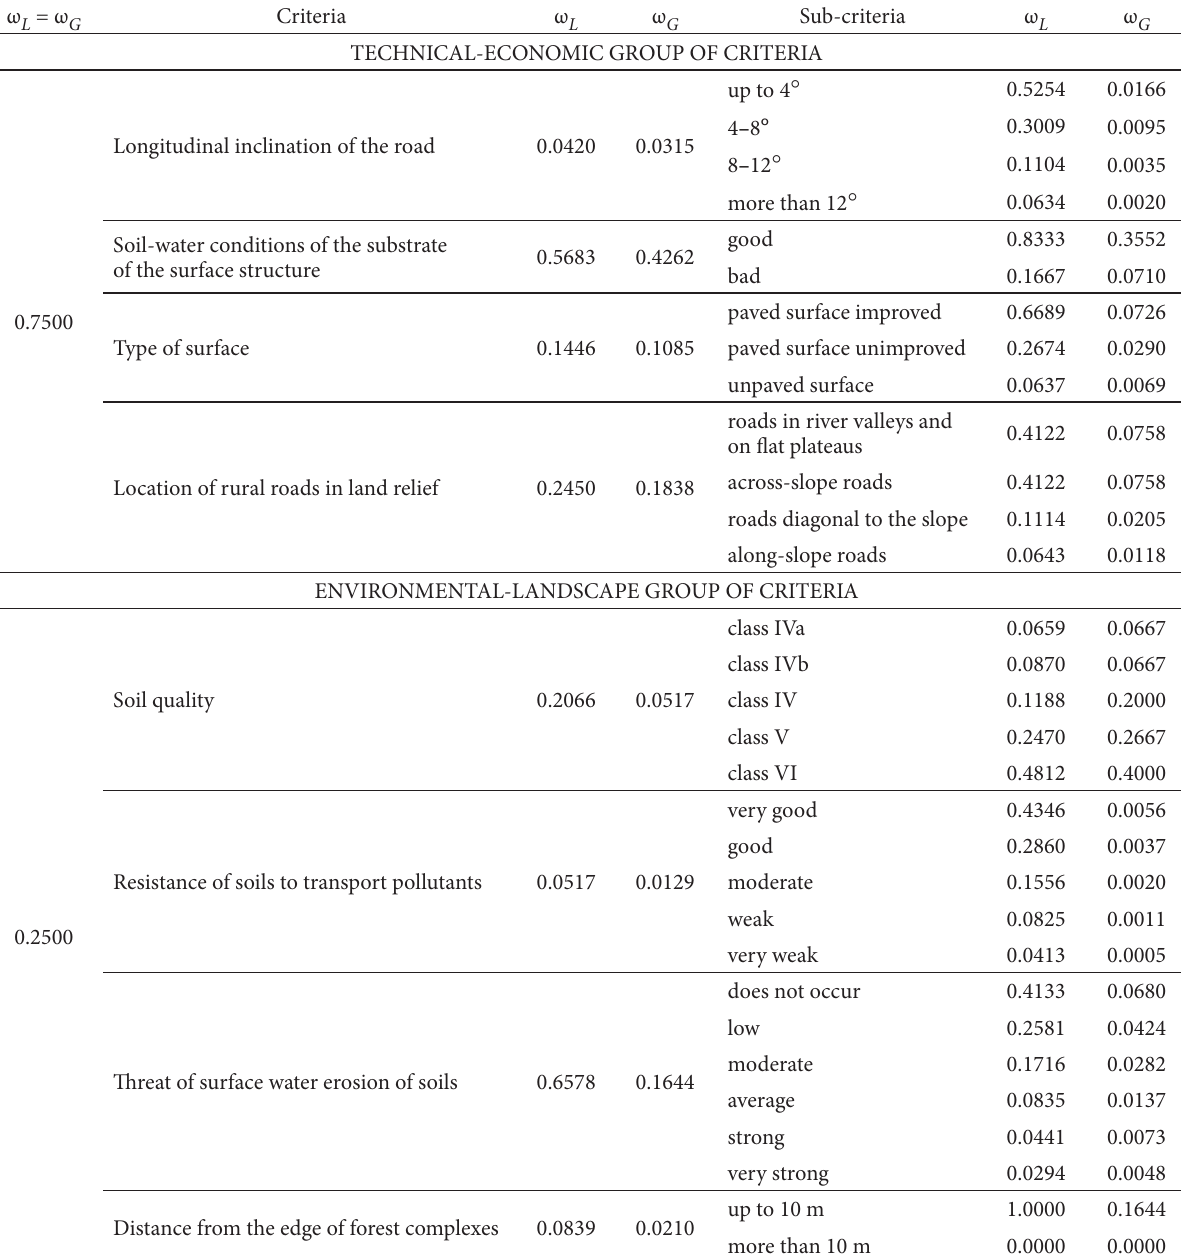
Table 2. Values of weights of criteria and sub-criteria considered in the analysis ω L = ω